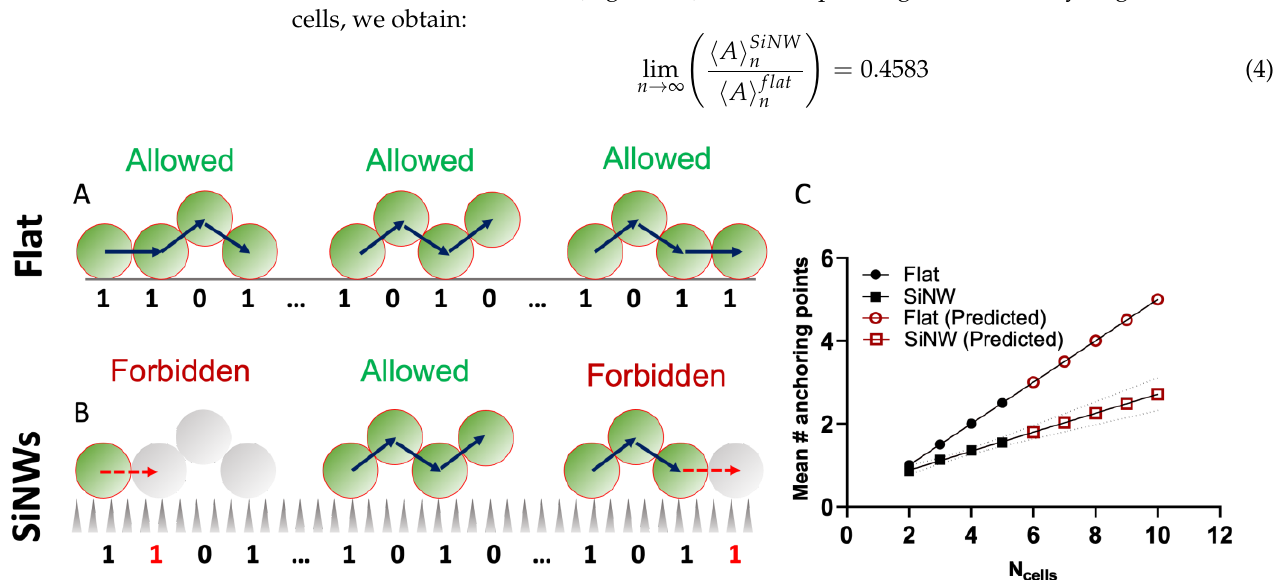
Figure 7. Effect of local topography on the average number of anchoring points for an ensemble of spherical cells: ( A , B ) Schematic representation of the topological selection rule from the model developed here; ( C ) Theoretical average number of anchoring points as a function of total number of cells for flat Si and SiNW surfaces. Red points are extrapolated from the fitting equations presented in Supplementary Materials S6.